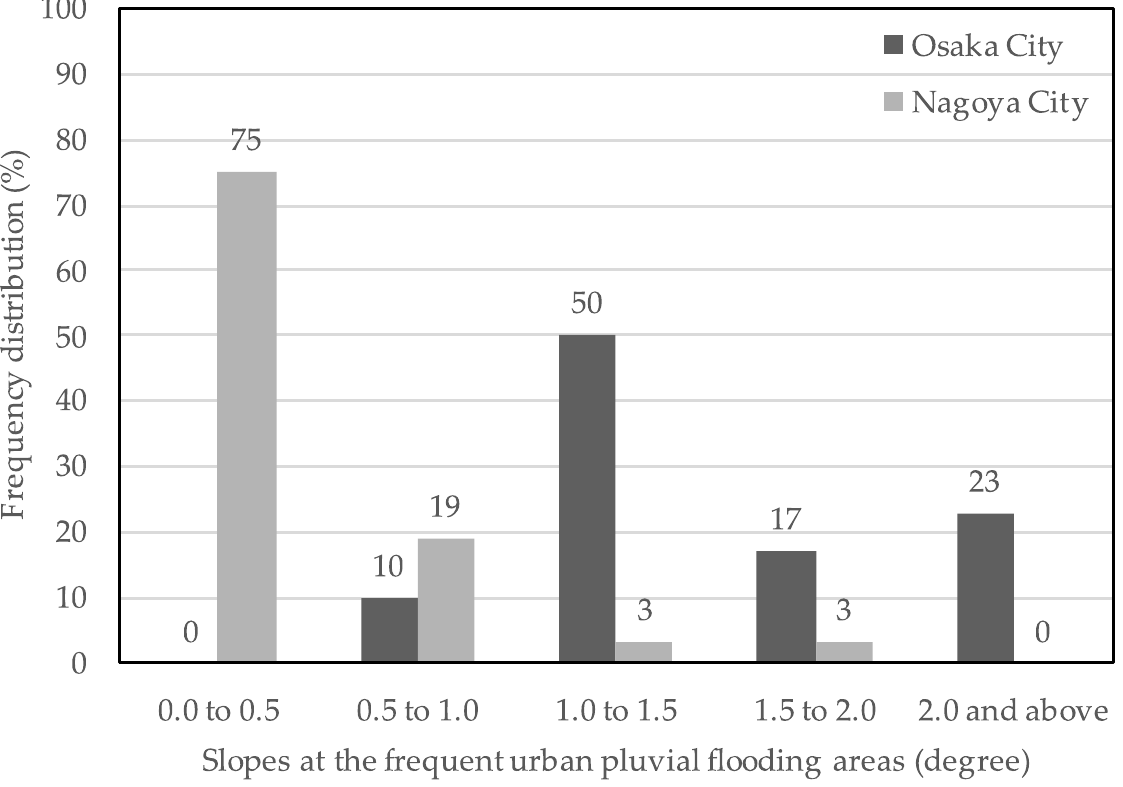
Figure 6. The frequency distribution of slopes at the frequent urban pluvial flooding areas in Osaka and Nagoya Cities.